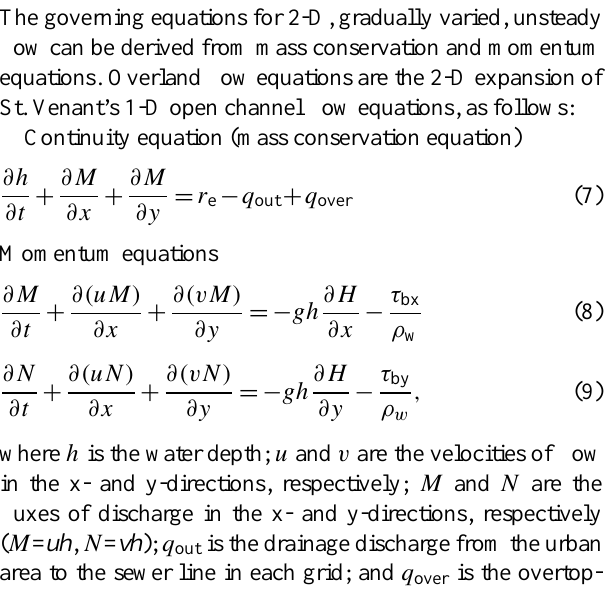
Fig. 3. Share rate of building per unit grid